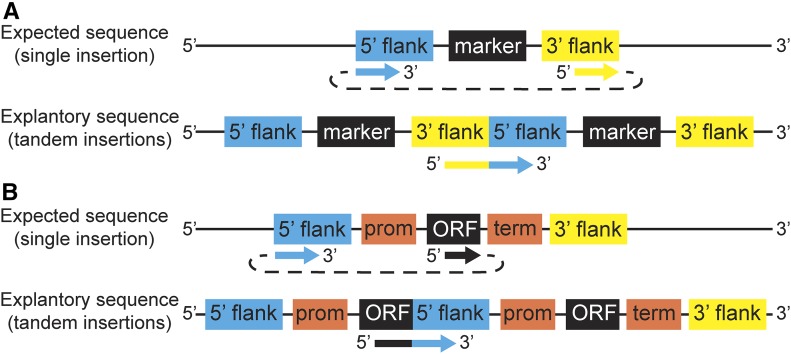
Evidence from split read alignments for tandem insertions. The top part of each panel shows the expected insertion and the aligned, observed sequence (colored arrows connected by a dotted line indicate the sequence of the read). The bottom part of each panel explains this observation. (A) Multiple insertions of the complete marker cassette with targeting flanks. (B) Partial sequences lacking the terminator and 3′ targeting flank.